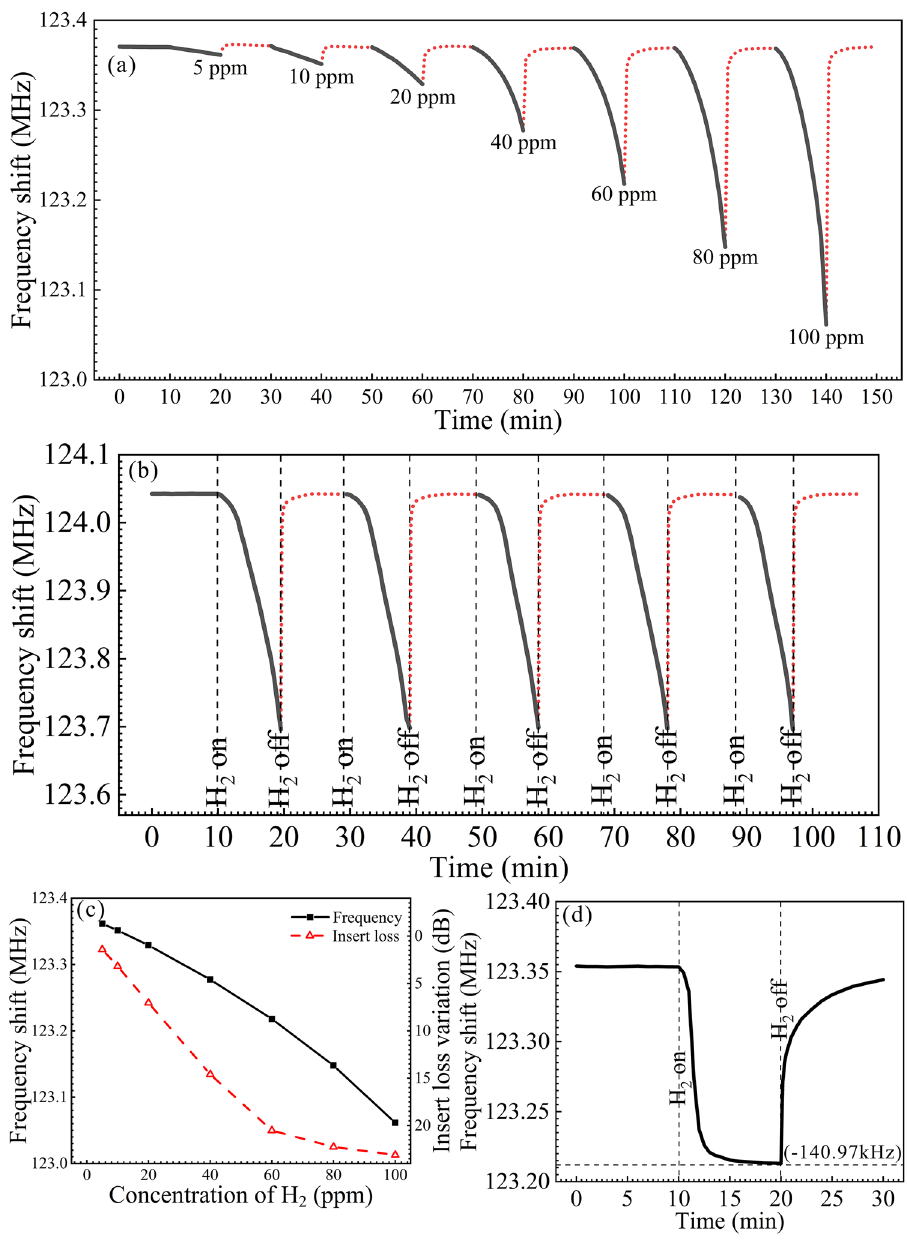
Figure 6. Response of the sensor to H 2 with different concentrations and NH 3 . ( a ) Dynamic responses of the sensor to H 2 with different concentrations mixed in argon. ( b ) Dynamic responses of the sensor to five cycles of H 2 of 100 ppm mixed in argon. To speed up the recovery process, we introduce wet air into the text box to exhaust H 2 in the experiments. ( c ) The frequency shift and loss variation versus the concentration of H 2 . ( d ) The frequency shift of the sensor to 100 ppm NH 3 mixed in argon with a relative humidity of